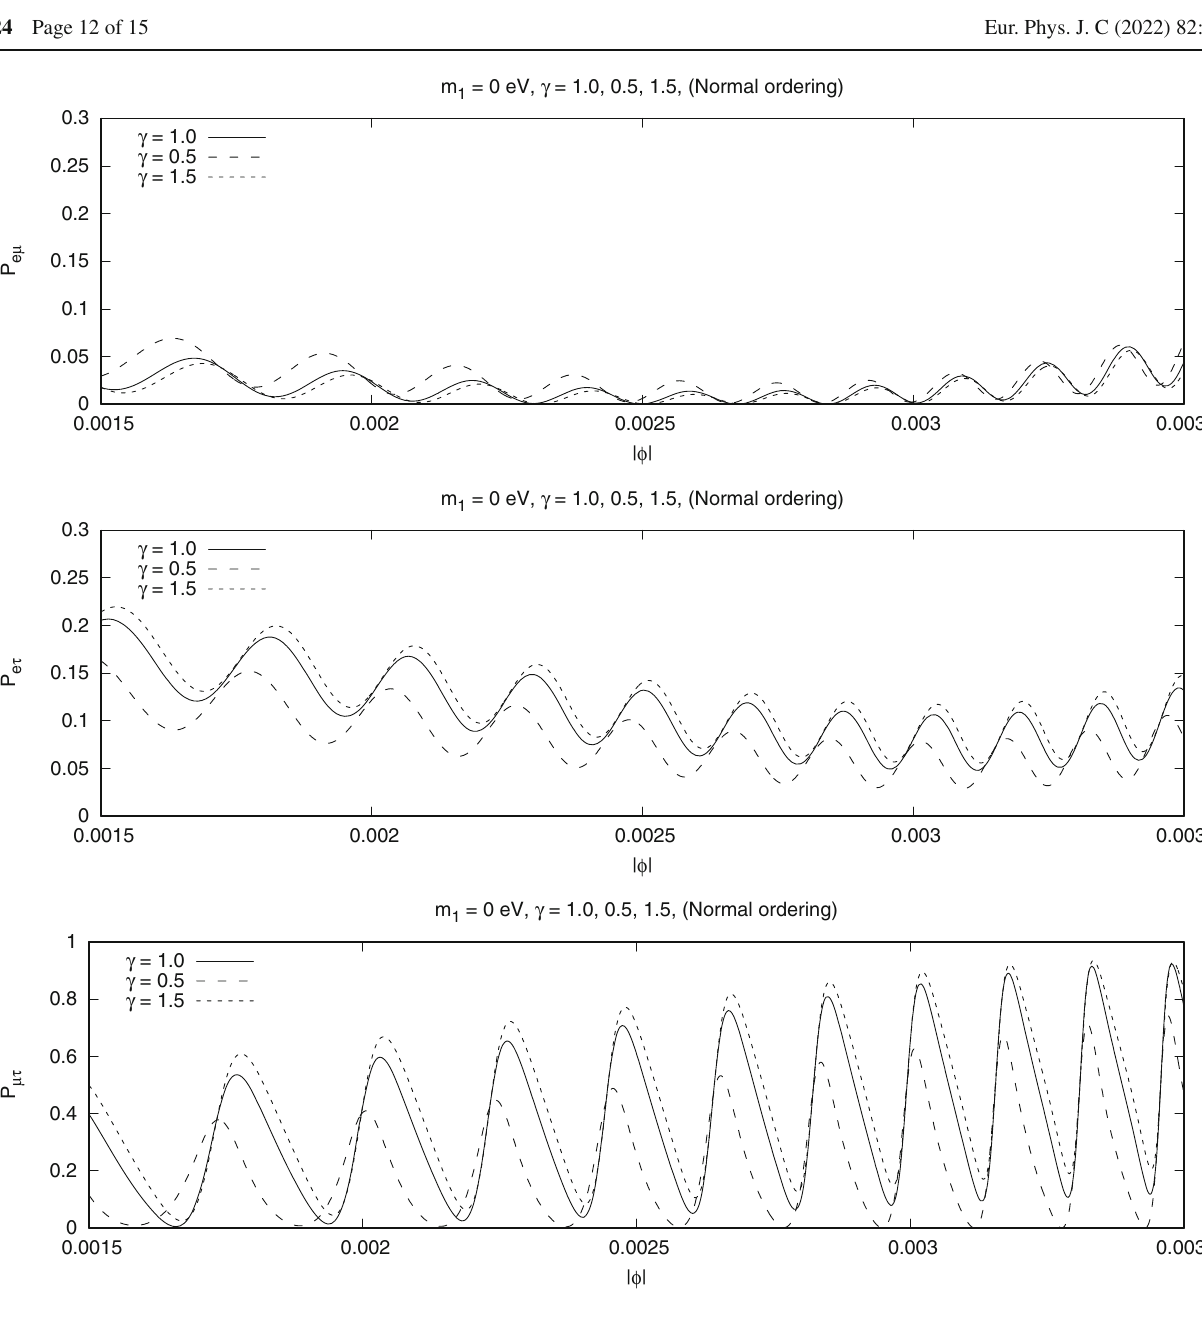
of ν μ → ν τ conversion for γ = 1 . 0 (solid line), γ = 0 . 5 (dashed line), γ = 1 . 5 (dotted line). We take r D = 10 8 km, r S = 10 5 r D , M ADM = 1 M (cid:15) and E 0 = 10 MeV. Neutrino mass squared differences, mixing angles and the Dirac CP phase are taken from the latest global fit